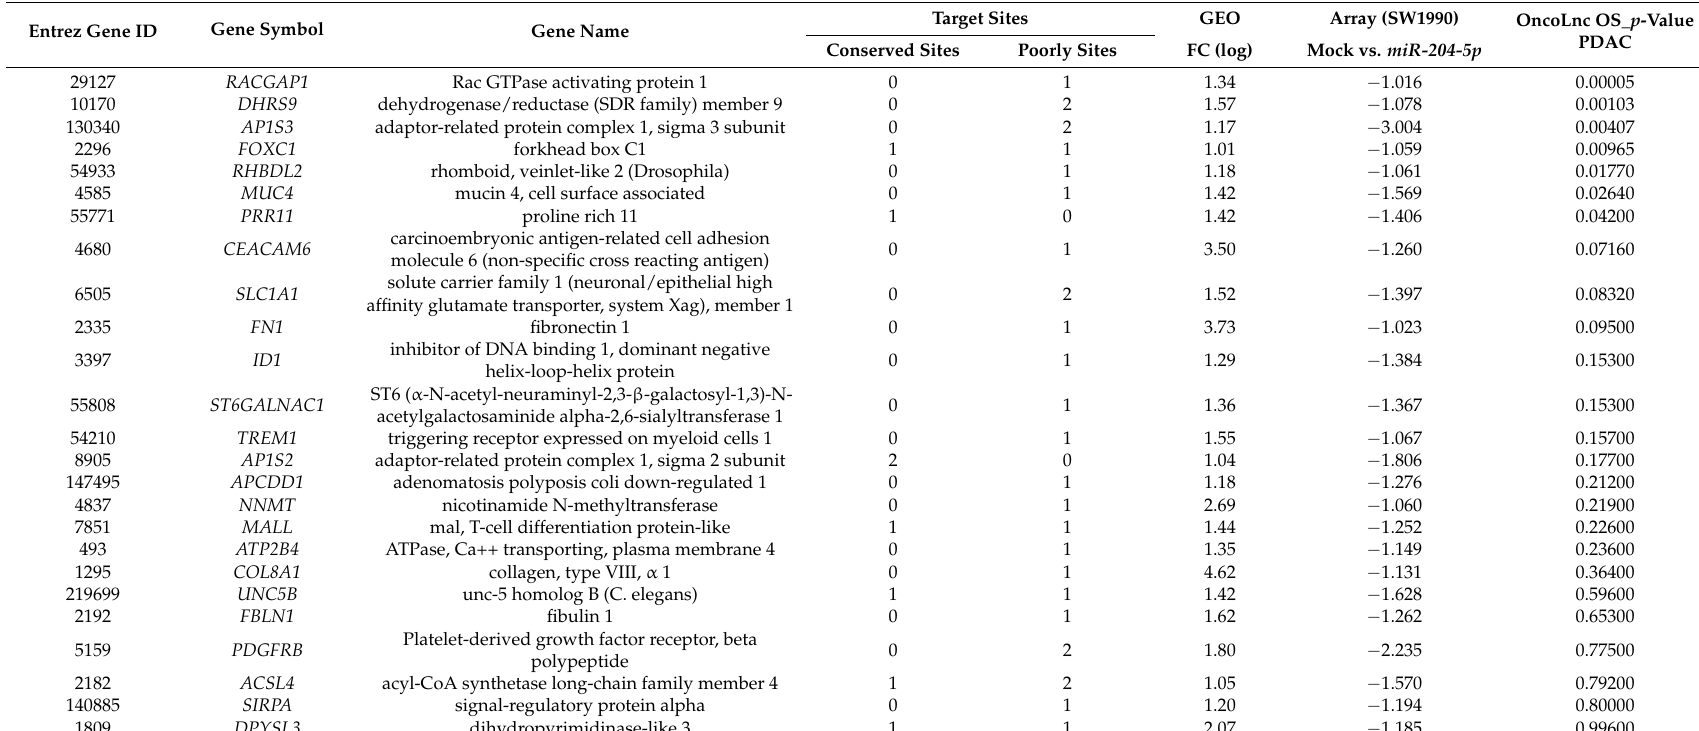
Table 3. Candidate target genes regulated by miR-204-5p